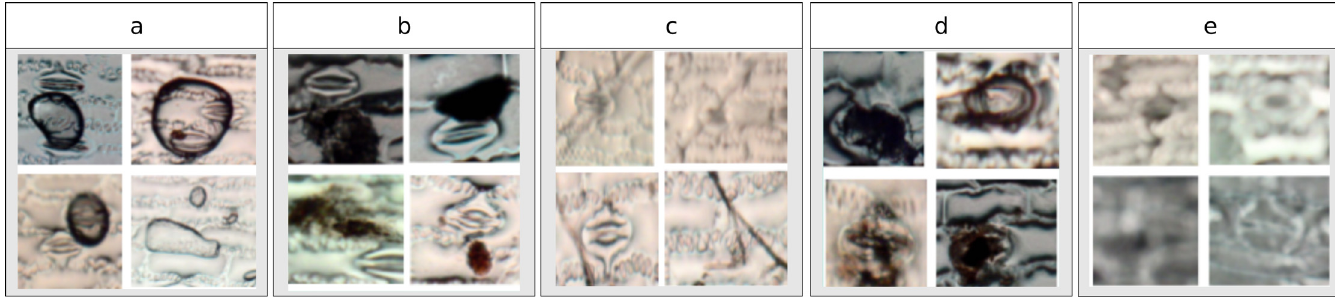
Fig 7. Different types of noise present in the microscopic images: (a) the usage of cyanoacrylate glue can generate air bubbles; (b) the microscope might capture leaves residuals; (c) the leaves might bend and create grooves in the image; (d) degraded stomata due to biological factors; and (e) low image quality due to equipment